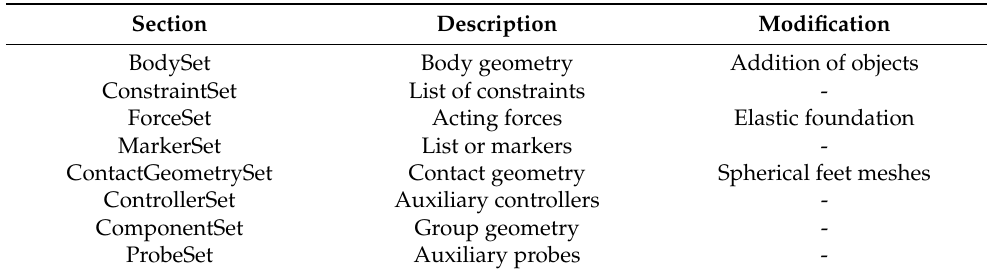
Table 1. The sections in the .osim file of the model developed in this study: some sections are left to their default state, others are modified. Section Description Modification BodySet Body geometry Addition of objects